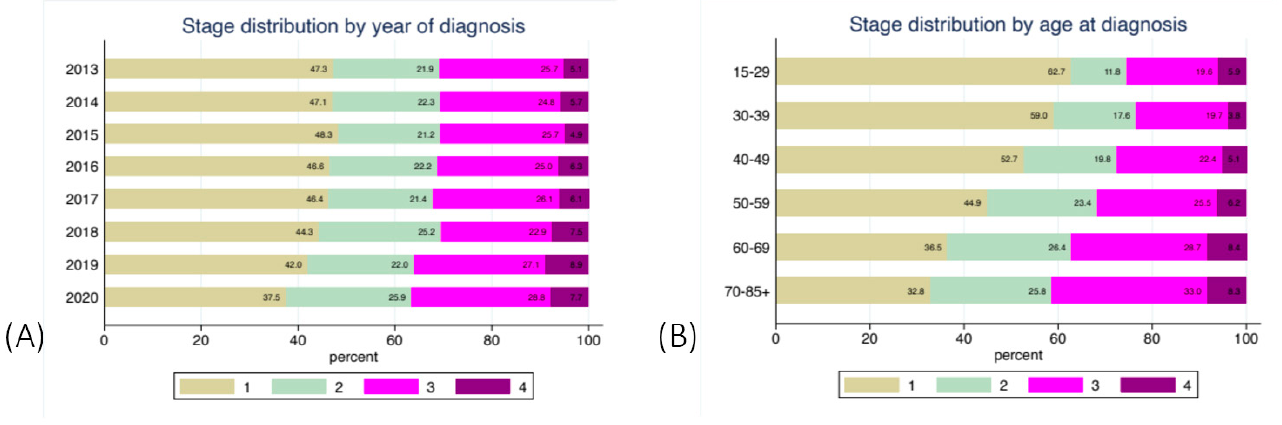
Figure 5. Distribution of stage of CUC (excluding those with unknown stage) by year ( A ) and by age ( B ).